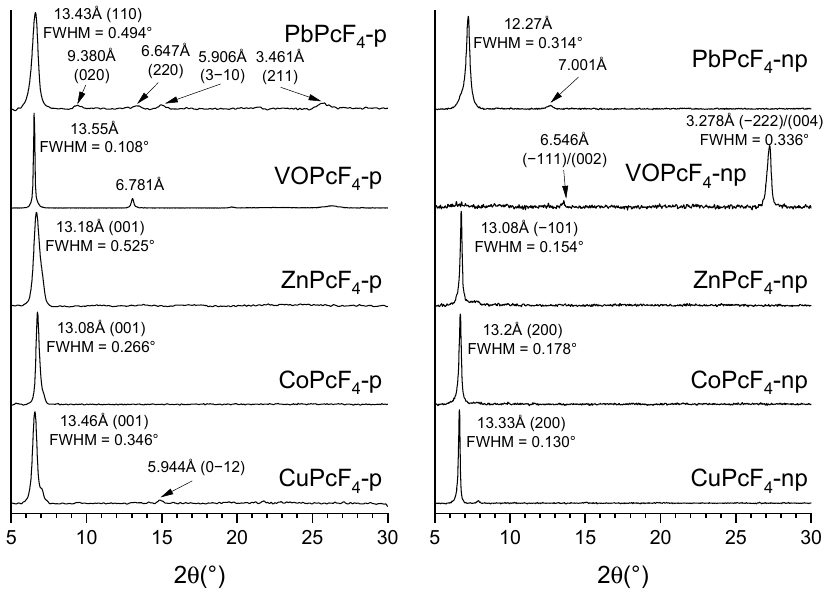
Figure 2. XRD patterns of MPcF 4 -p and MPcF 4 -np thin films in the 2 θ range of 5–30 ◦ . The X-ray pattern of the PbPcF 4 -p film has several weak diffraction peaks in addition to the main peak, which coincide with the data of the single crystal [20]. This indicates a weak preferred orientation in the thin film. Finally, the diffractogram of the PbPcF 4 -np film has one strong diffraction peak and one weak diffraction peak, neither of which correspond to the data of the single crystal. This means that the PbPcF 4 -np film consists of an unknown crystalline phase but has a more preferred orientation compared to PbPcF 4 -p.